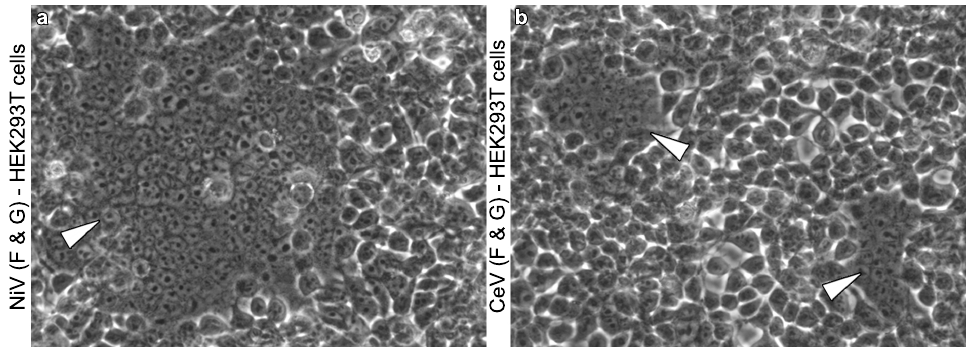
Figure 2. Henipavirus-induced syncytia in vitro. ( a , b ) HEK293T cells transfected with the G and F proteins of NiV ( a ) and CedV ( b ) in vitro. White arrowheads point towards syncytia (( a ): one large syncytium encompassing more than 100 nuclei; ( b ): two syncytia encompassing